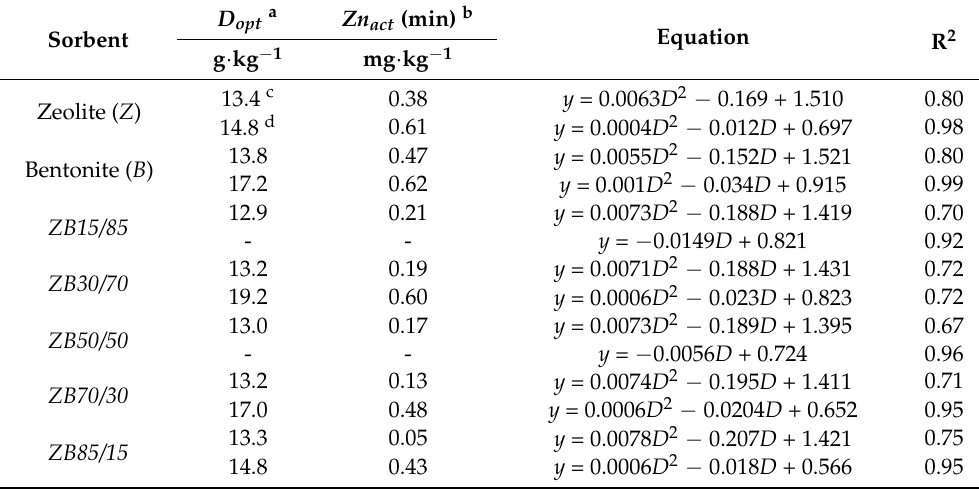
Table 5. Regression models elaborated for active Zn ( Zn act ) fractions in treatments with sorbents after 115 days of